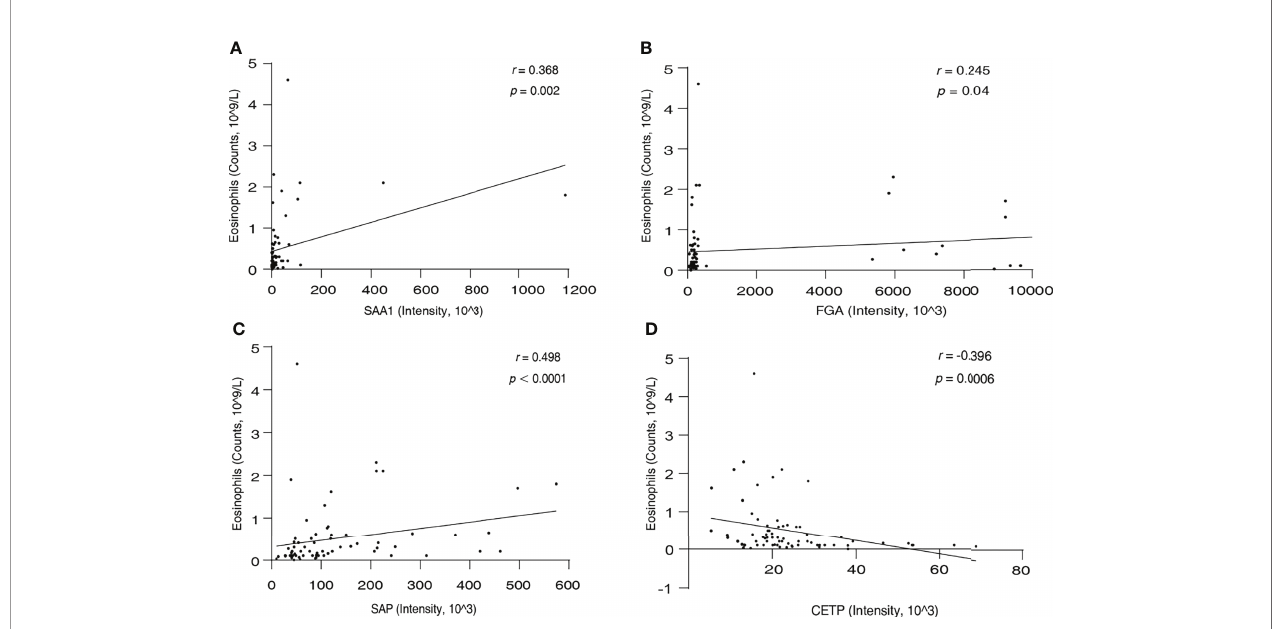
FIGURE 5 | The correlation between serum SAA1 (A) , FGA (B) , SAP (C) , CETP (D) , and eosinophil